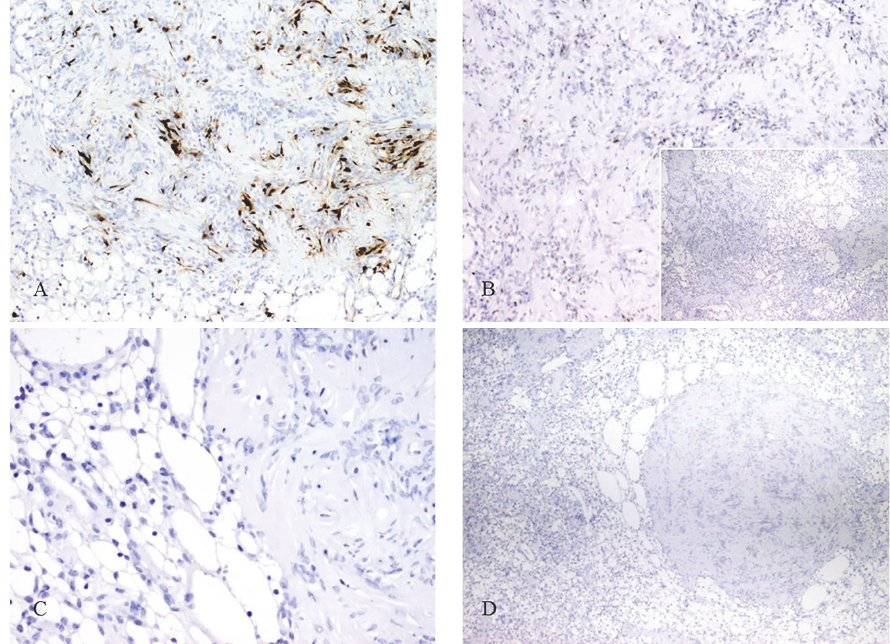
Figure 3: Photomicrographs of immunohistochemical stains: (A) S-100 (400x): nuclear and cytoplasmic staining in tumor cells, (B) progesterone receptor (400x): focal staining and (B inset) estrogen receptor (100x): no staining in tumor, and (C) GFAP (400x) and (D) EMA (100x): negative staining in